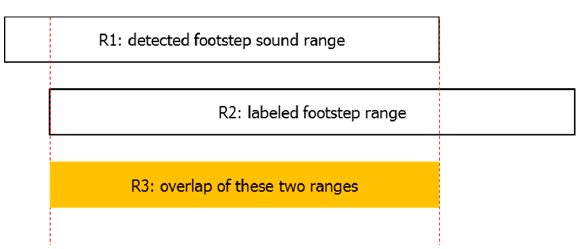
Figure 10. Relationship between detected footstep sound range and labeled footstep range.